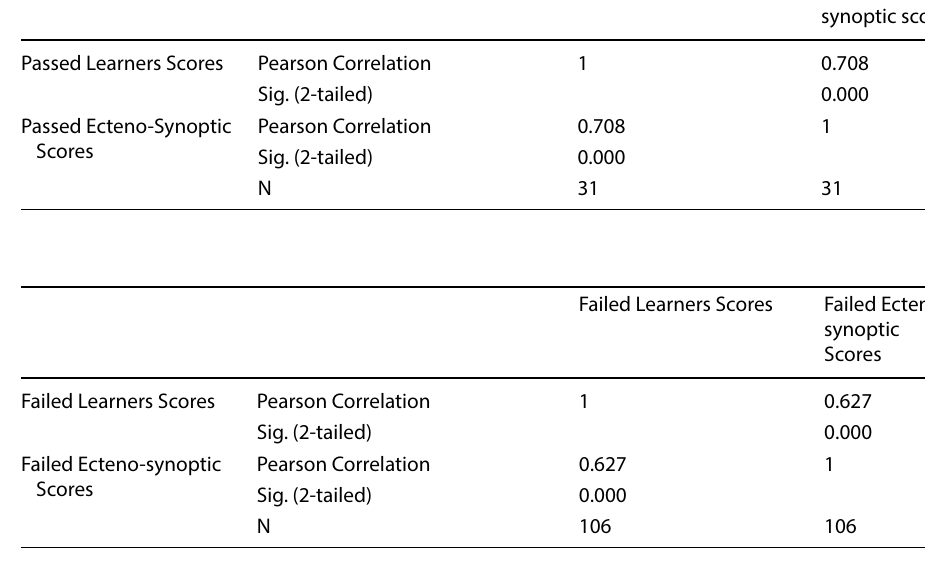
Table 3 The Correlation between Passed Ecteno- Synoptic Score and their Reading Scores